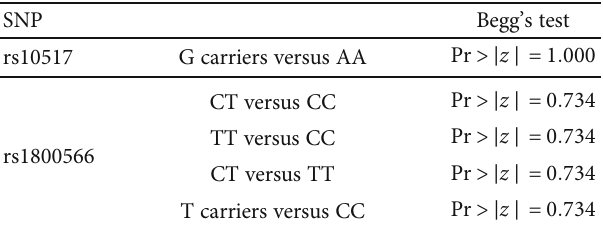
Table 3: Begg ’ s test for each meta-analysis. SNP Begg ’ s